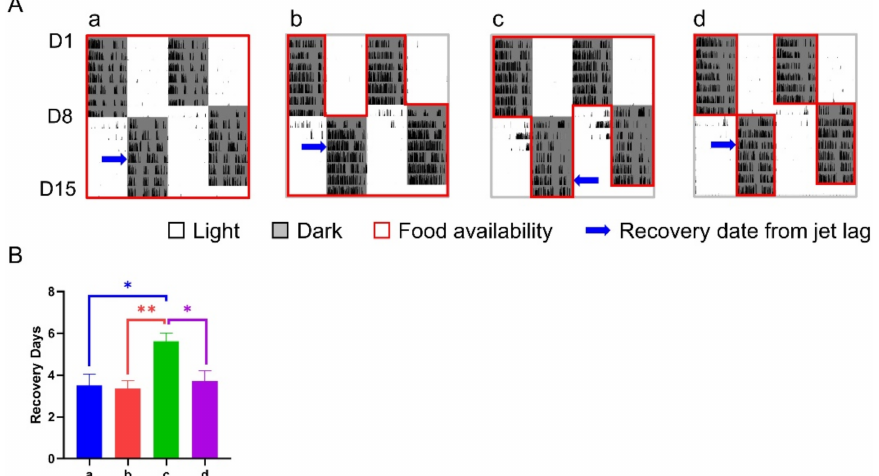
Figure 6. Effect of 12-h TRFs on behavioral adaptation in mice treated with a 12-h shift. ( A ) Repre- sentative double-plotted actograms of wheel running activity of mice in groups a–d. ( B ) Days for recovery from the shift. ** p < 0.01; * p < 0.05, one-way ANOVA with Tukey’s multiple comparisons test ( n =